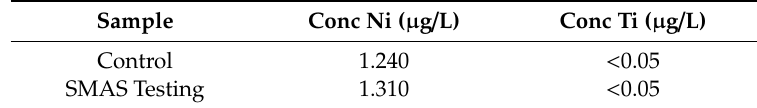
Table 1. Ni and Ti ion concentrations from NiTi archwire in CACO-2 cell culture mediums after exposure with without loading (as a control sample) and after SMAS